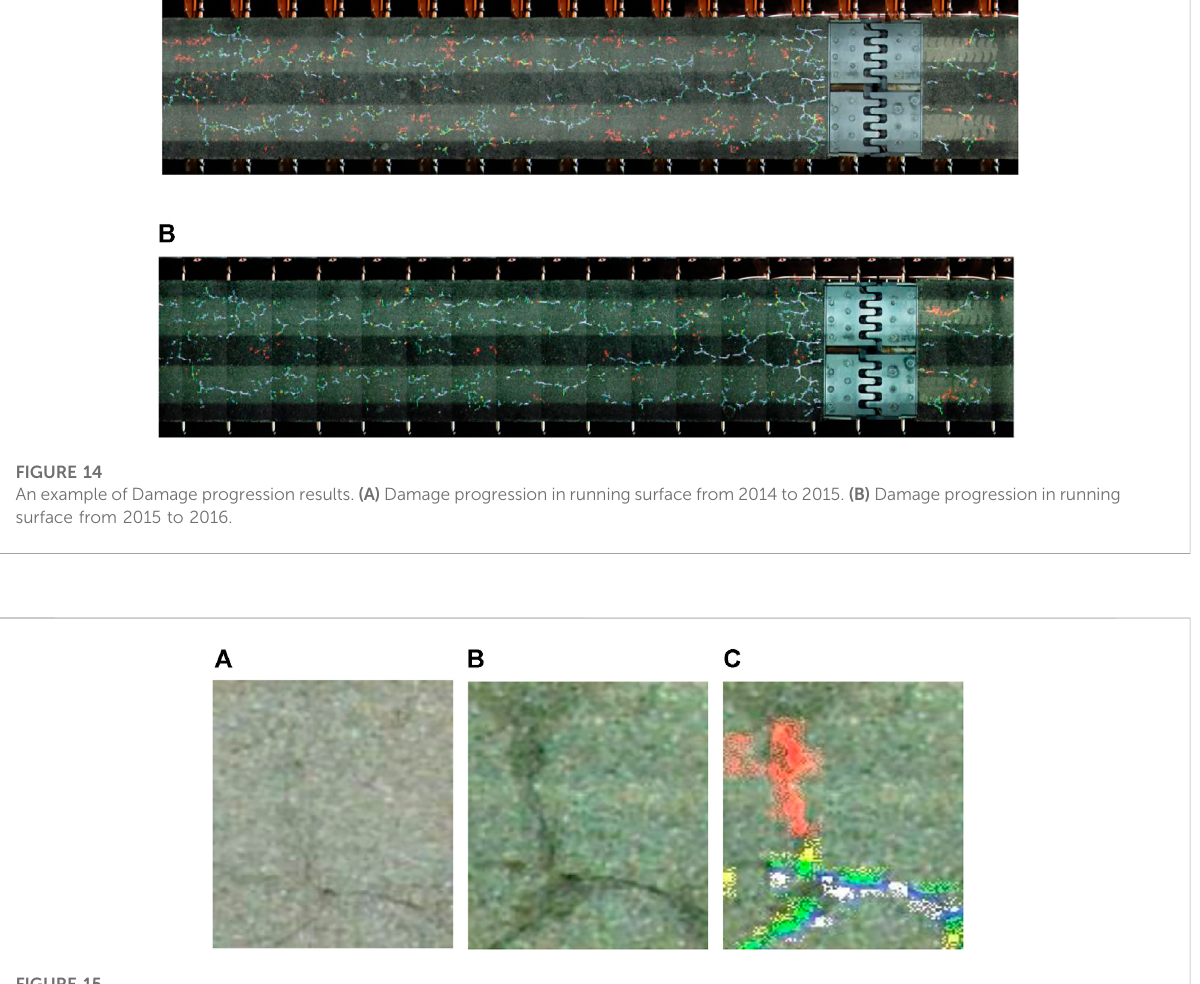
FIGURE 15 The detail of crack progression results. (A) Surface in 2015. (B) Surface in 2016. (C) Progression results of